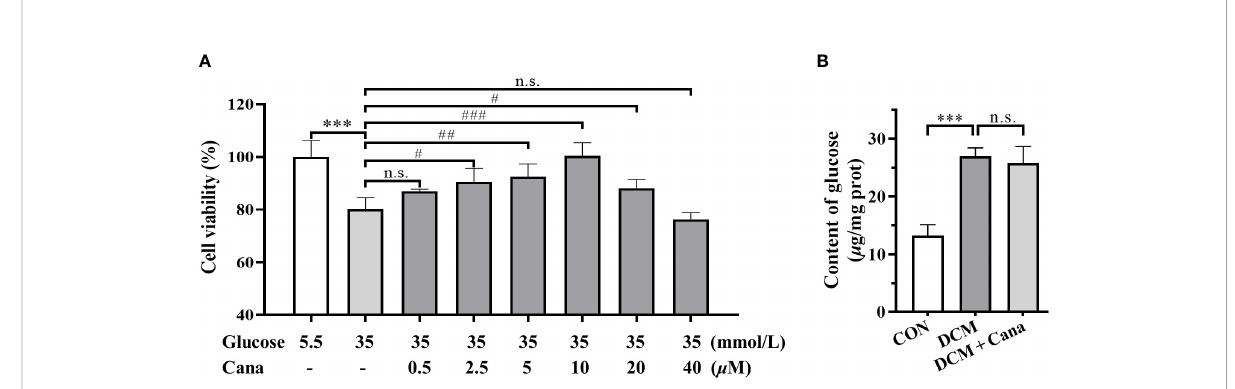
FIGURE 3 Canagli fl ozin alleviates high glucose injury of cardiomyocytes by non-hypoglycemic way. (A) Effects of high concentration of glucose and different concentrations of canagli fl ozin on the cell viability of H9C2 cells. (B) Content of glucose in H9C2 cells of each group. (***: P<0.001; compared with CON group; #: P< 0.05; ##: P<0.01; ###: P<0.001; compared with HG group; n.s.: no signi fi